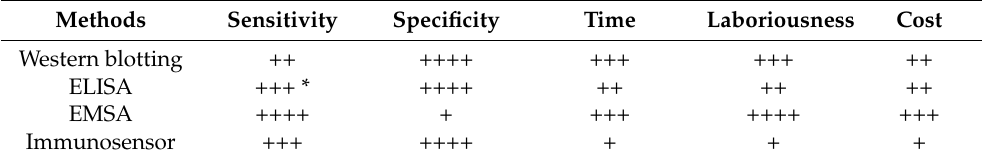
Table 1. Merits and demerits of HMGB1